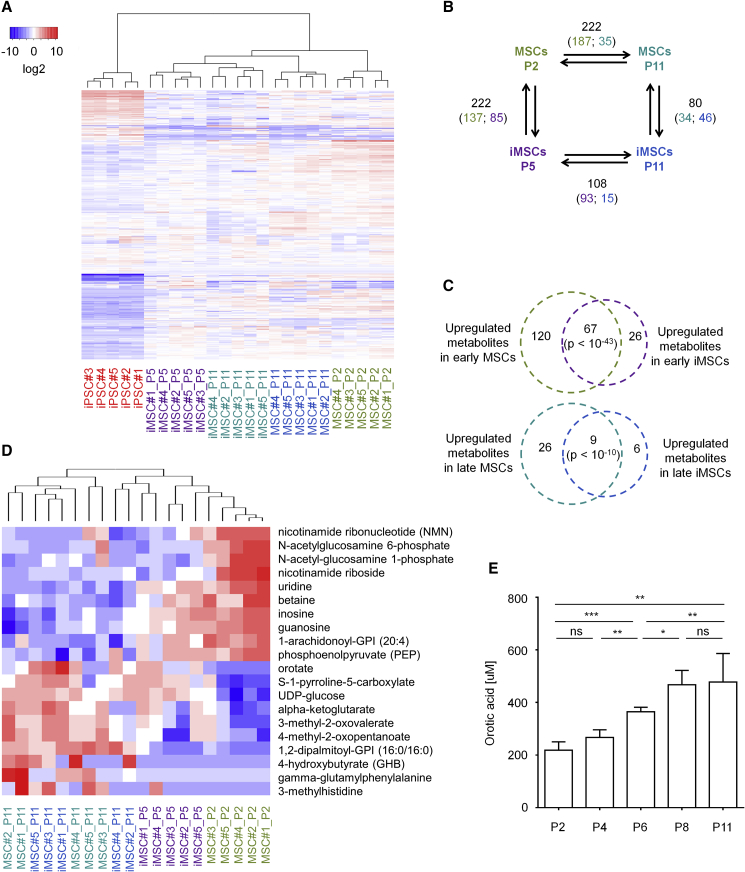
Metabolomic Characterization of Replicative Senescence(A) Heatmap presentation of metabolomes (612 different metabolites). Hierarchical clustering clearly separated iPSCs, MSCs, and iMSCs, as well as cells at early and late passage (n = 5, donor numbers are indicated).(B) Schematic presentation of the numbers of metabolites with significant differences in pairwise comparisons (1.5-fold difference and adjusted p < 0.05; higher abundance is indicated by the color code of corresponding cell type).(C) The Venn diagrams depict a high overlap of senescence-associated changes in MSCs and iMSCs for upregulated and downregulated metabolites (significance was estimated by hypergeometric distribution).(D) Heatmap of the ten most significant up- and downregulated metabolites during replicative senescence (MSCs + iMSCs).(E) Orotic acid was exemplarily measured by a fluorogenic assay in MSCs (n = 4 biological replicates) and increased over subsequent passages, which is in line with our metabolomics results. * p. < 0.05; ** p < 0.005 and *** p < 0.001.